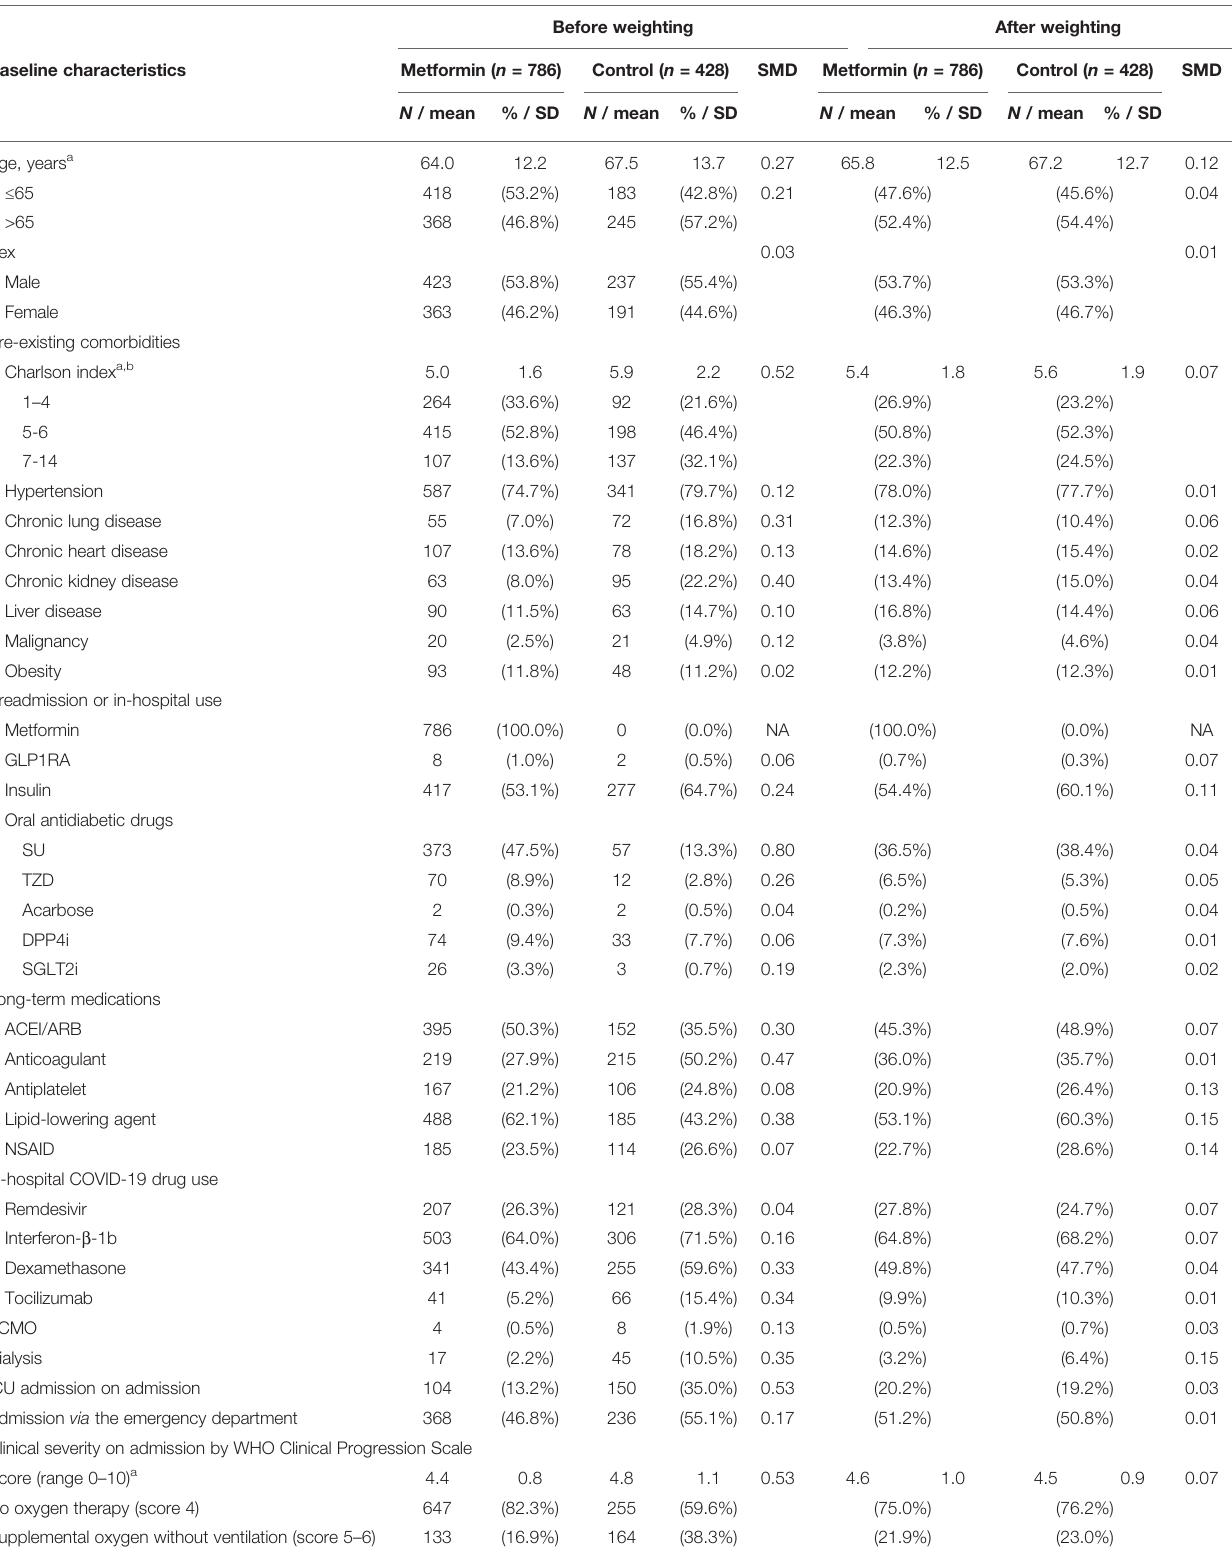
TABLE 1 | Baseline characteristics of T2DM patients hospitalized with COVID-19 by exposure to metformin after multiple imputation and propensity score weighting. Before